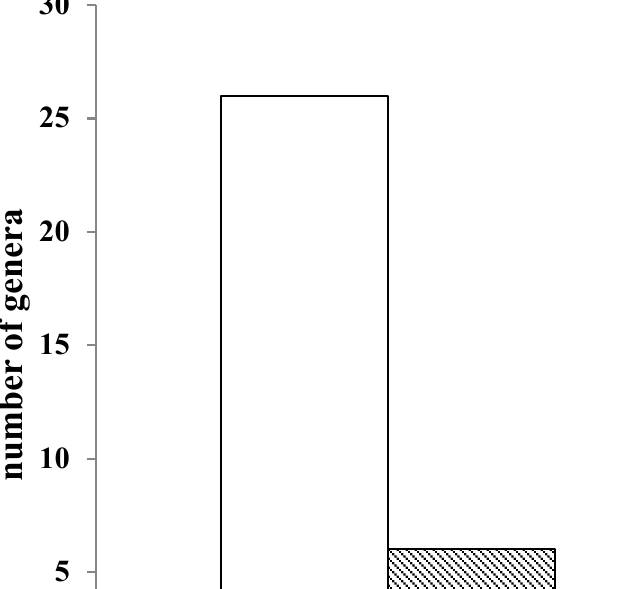
Figure 2. Frequency of genera of filamentous fungi recorded in small sewage treatment plants;